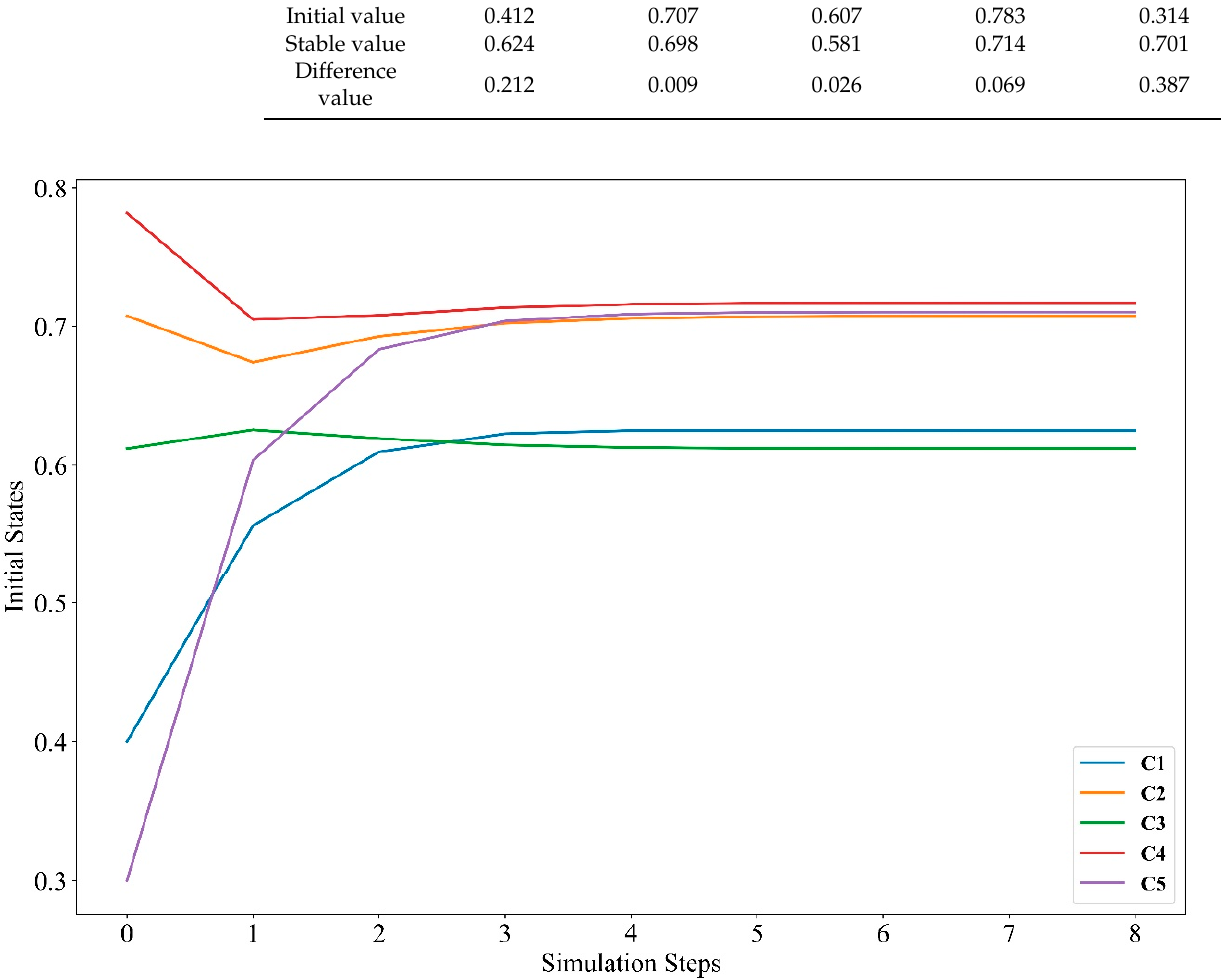
Figure 16. Simulation results for the 8 concept nodes: C1—PSR distribution; C2—Lunar surface slope; C3—Rocks distribution; C4—Illumination intensity; and C5—Maximum temperature.